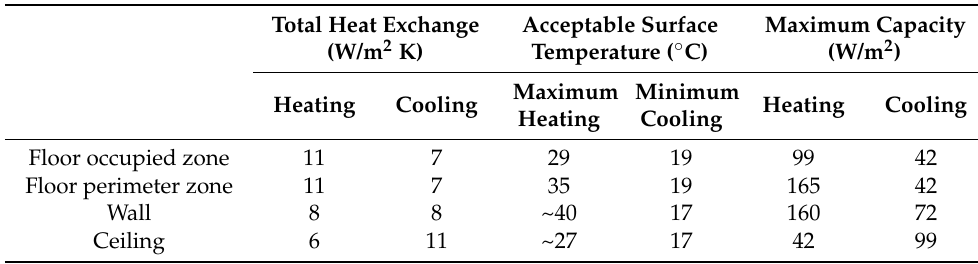
Table 2. Maximum capacity of radiant systems. Source: REHVA Handbook [34]. Source: Remade by the third